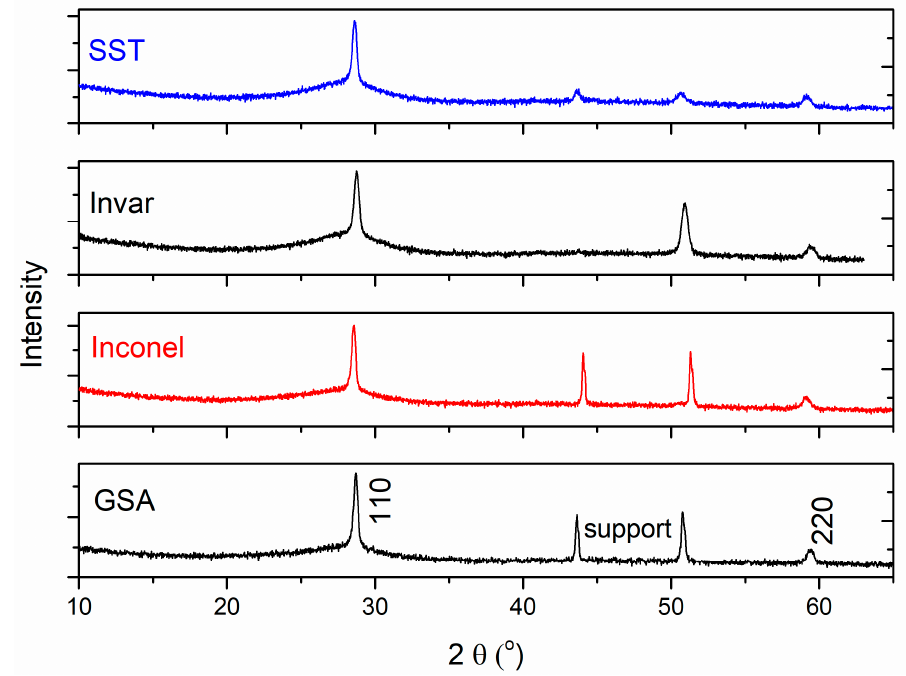
Figure 6. XRD patterns of the films deposited on different substrates at a temperature of 600 °C and with a deposition rate of 12 Å/s.